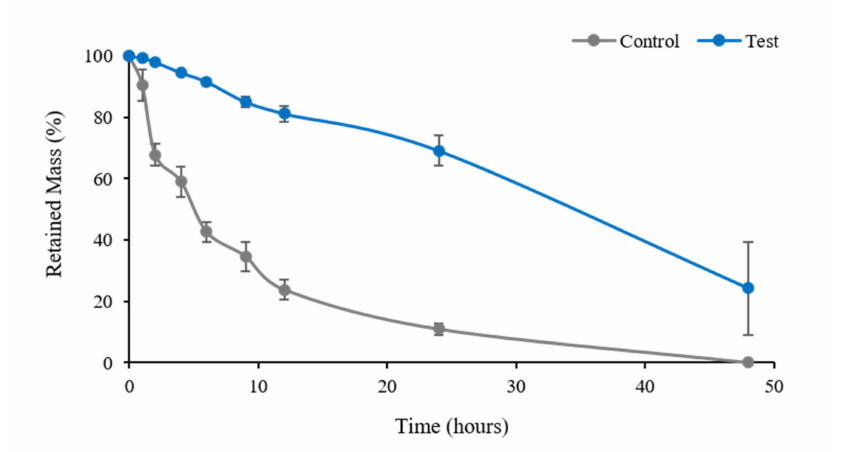
Figure 4. Results of comparative experiment on enzymatic degradation of two types of membranes. Control is represented by non-cross-linked collagen membrane; Test is represented by EDC-cross-linked collagen